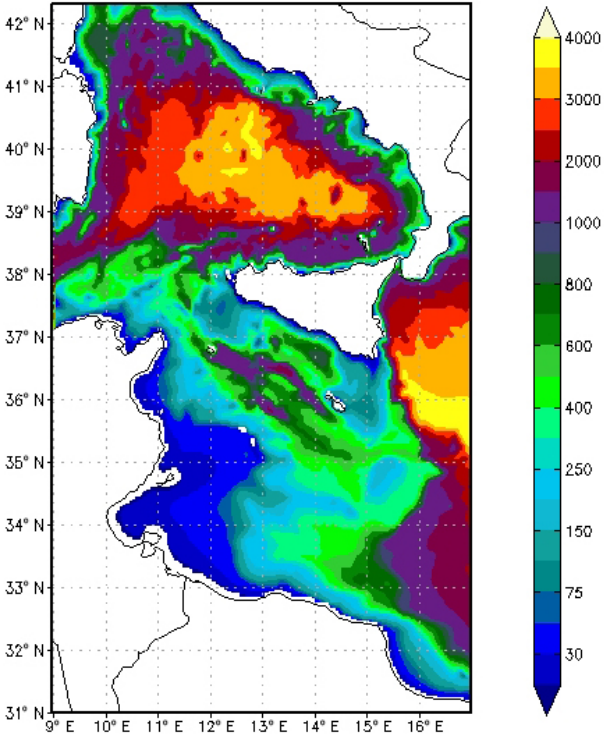
Figure 1. Geographical domain of the Tyrrhenian Sicily Channel Regional Model (TSCRM). The color scale represents the sea bot-